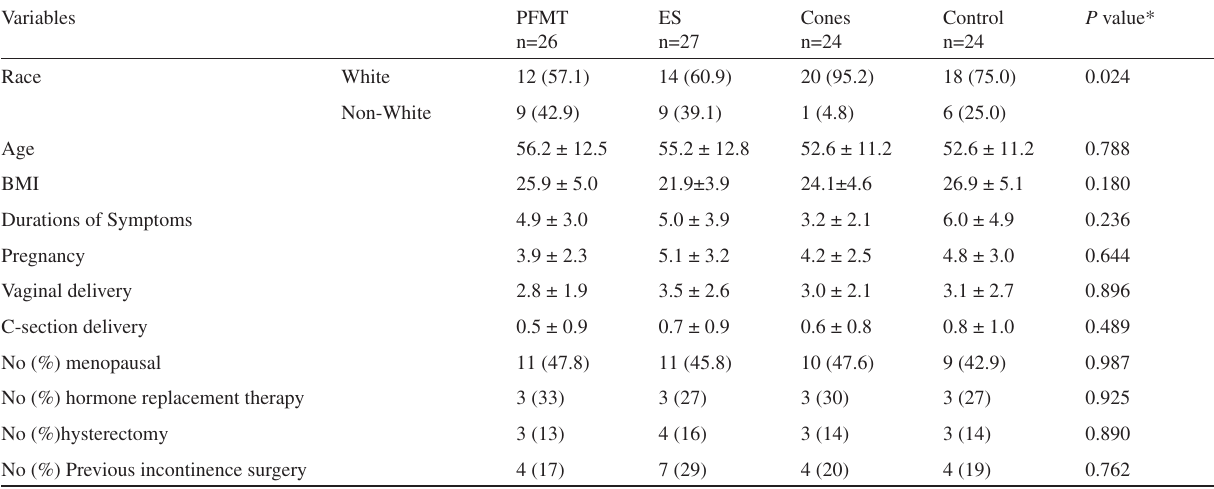
Table 1 - Baseline demographic and clinical characteristics by treatment group